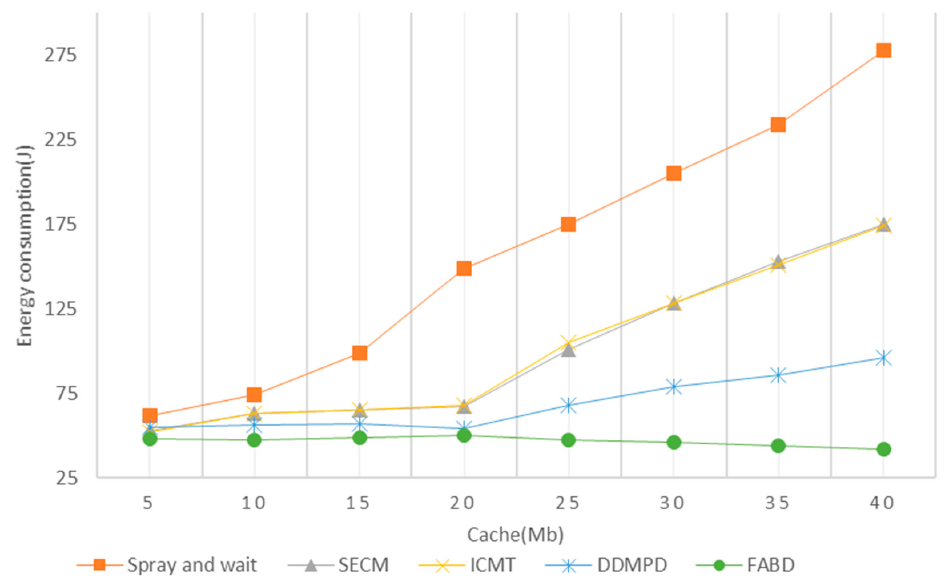
Figure 10. The relationship between energy consumption and cache.